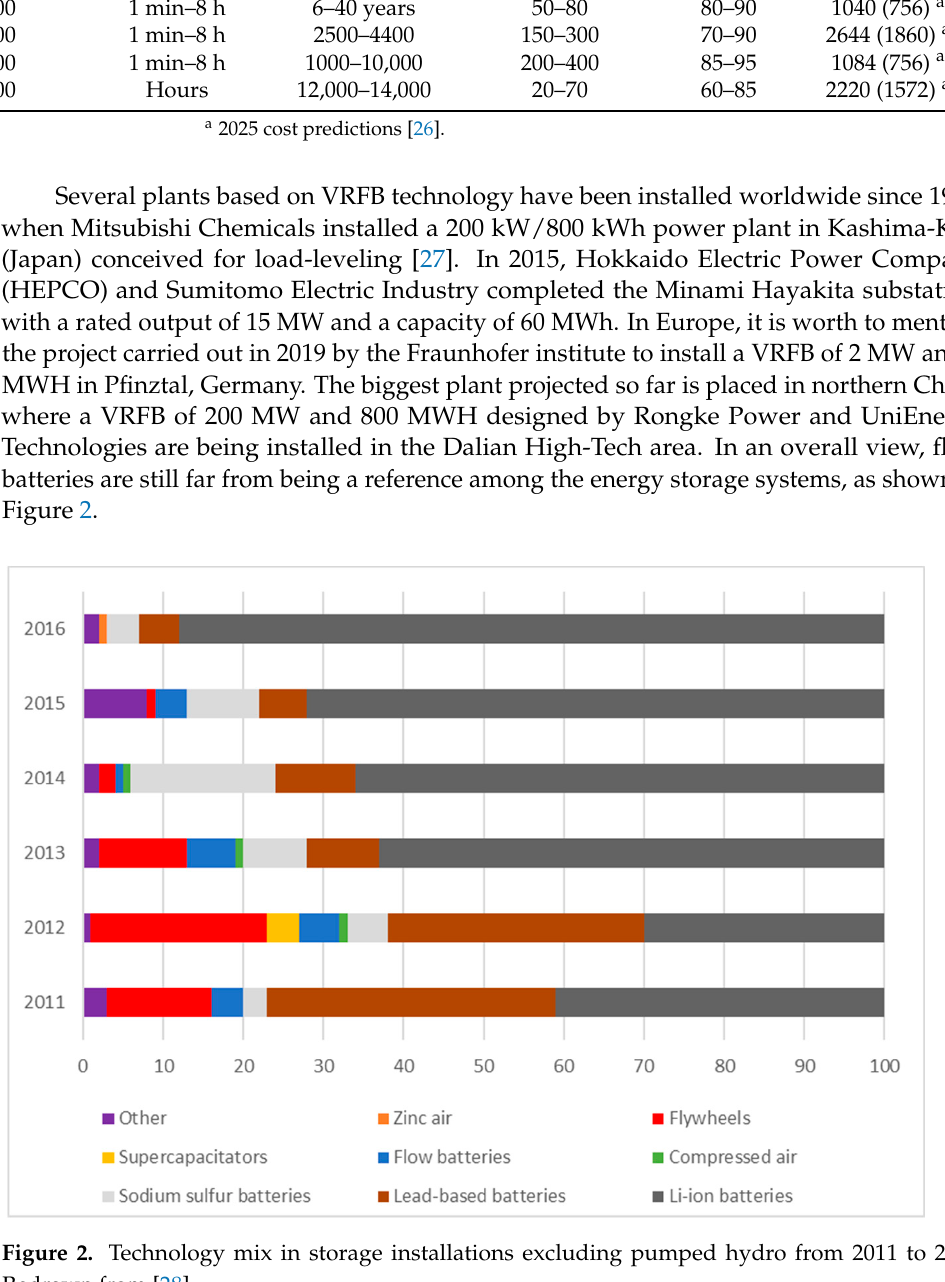
Table 1. Main characteristics of various Energy Storage Systems.